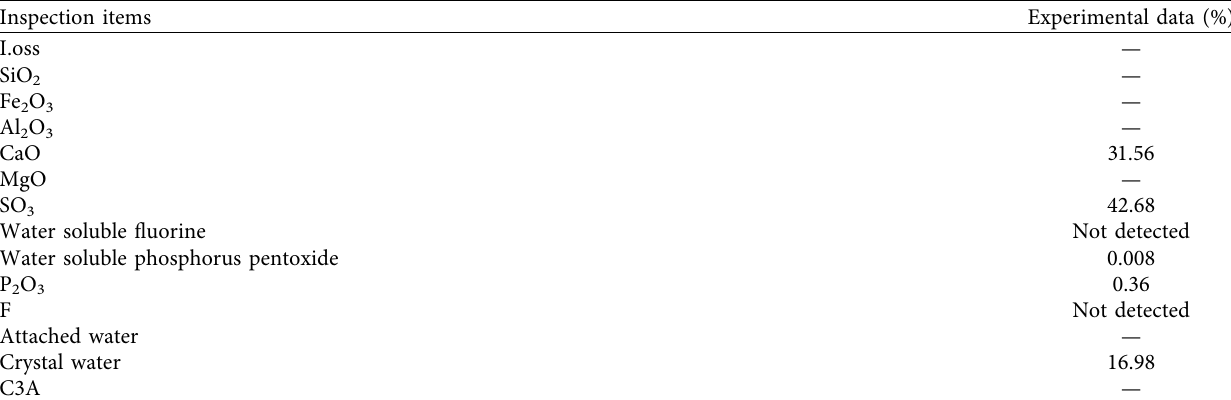
· 2H 4 2 O) properties.